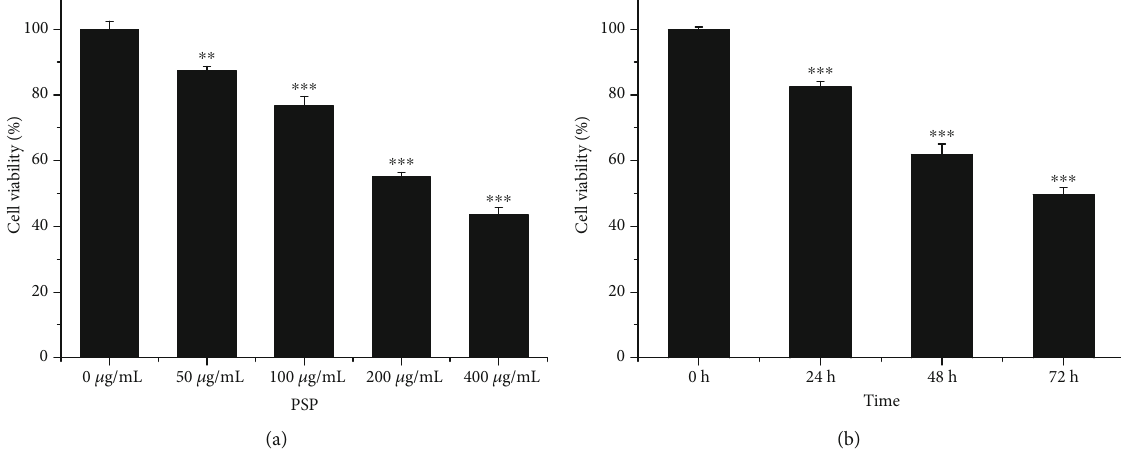
Figure 2: The proliferation of esophageal squamous cell carcinoma Eca109 cells was inhibited by PSP. (a) The toxicity of di ff erent concentrations of PSP on Eca109 cells (culture for 48h) measured with CCK8, compared with the control group, ∗∗ p < 0 : 01 ; ∗∗∗ p < 0 : 001 . (b) The toxicity of PSP on Eca109 cells after di ff erent durations (200 μ g/mL PSP) measured with CCK8, compared with the control group; ∗∗∗ p < 0 : 001 . The proliferation of Eca109 cells in each group measured by CCK8 assay. Compared with the control group: ∗∗ p < 0 : 01 and ∗∗∗ p < 0 : 001